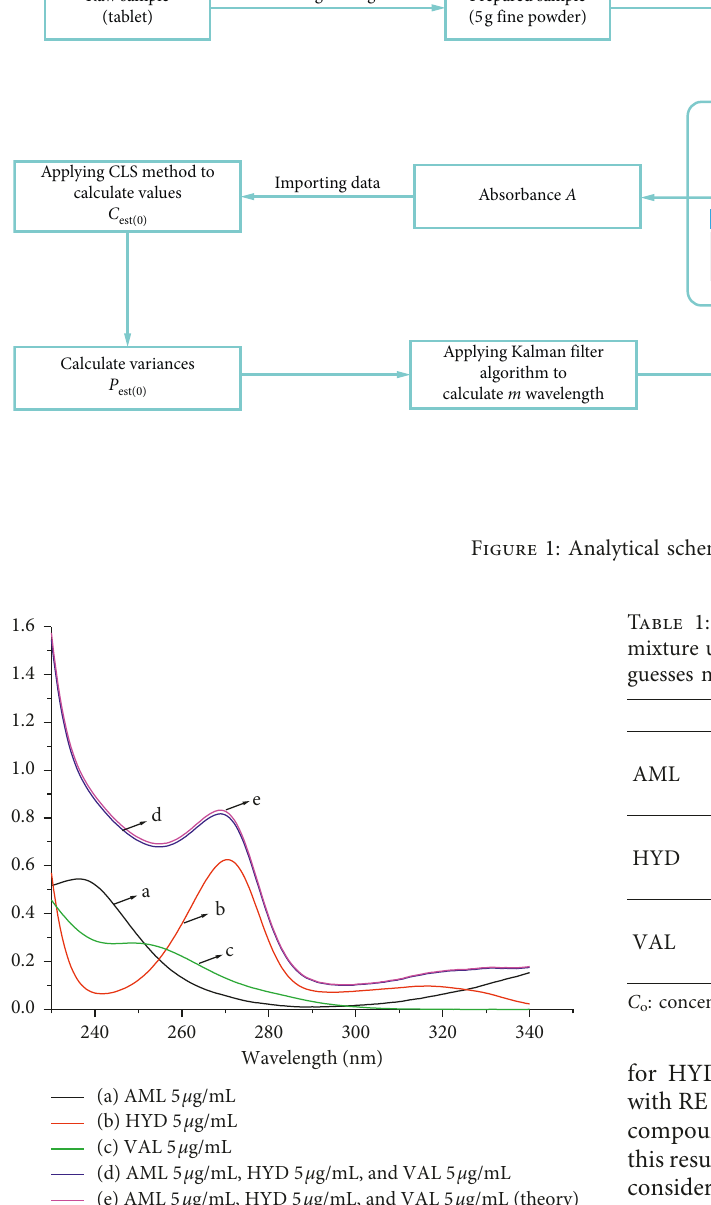
Figure 2: Measured absorbance spectra of the standards AML 5 µ g/ mL (a), HYD 5 µ g/mL (b), VAL 5 μ g/mL (c), and mixture of AML 5 µ g/mL, HYD 5 µ g/mL, and VAL 5 μ g/mL (d) in methanol. The theory spectrum is demonstrated as